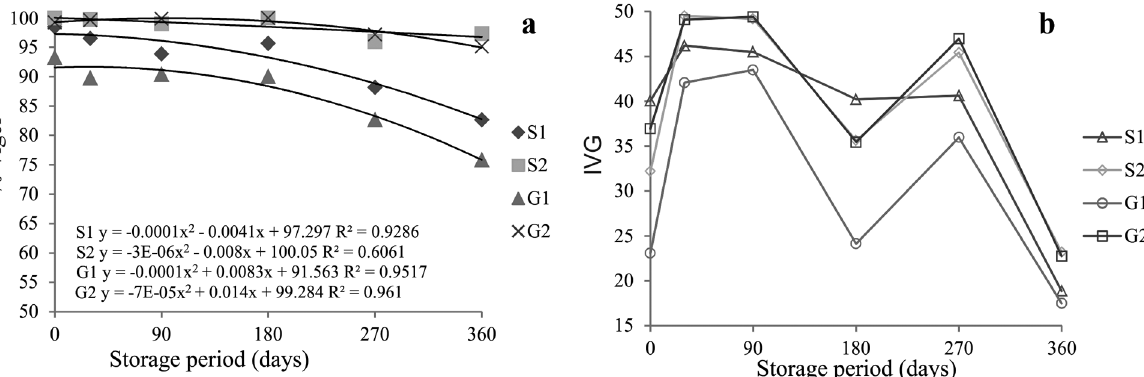
Figure 4 - Signi fi cant regression model to vigor by cold test (a) , and germination velocity index (b) of beans seeds and grains, of BRS Splendor variety, during storage periods. S1 and G1 seeds and grains from fi eld 1, S2 and G2 seeds and grains from fi eld 2, respectively Cascavel,